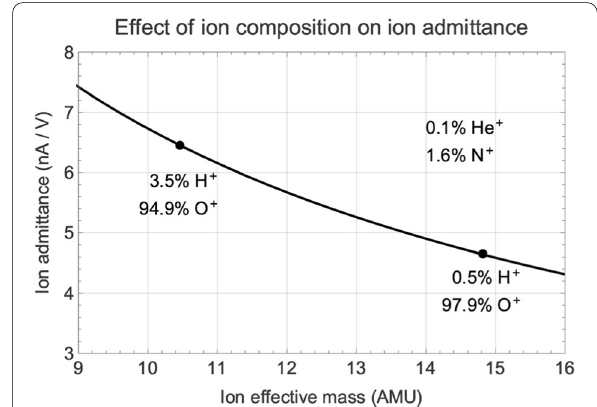
Fig. 10 Illustration of the large sensitivity of ion admittance to small variations in light ion composition. The point at lower right is the theoretical admittance for the Swarm A dayside ascending overflight of the Jicamarca incoherent scatter radar facility, using the radar estimates for electron density and temperature and IRI estimates for ion composition. An increase to 3.5% H with concomitant decrease + to 94.9%